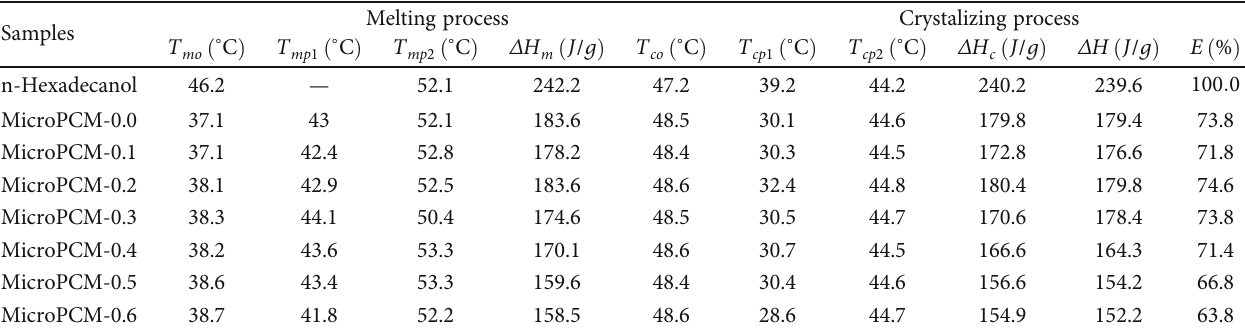
Table 2: Characteristics of the n-hexadecanol and microencapsulated PCM improved with hydroxylated carbon nanotubes in varied quantities. Samples